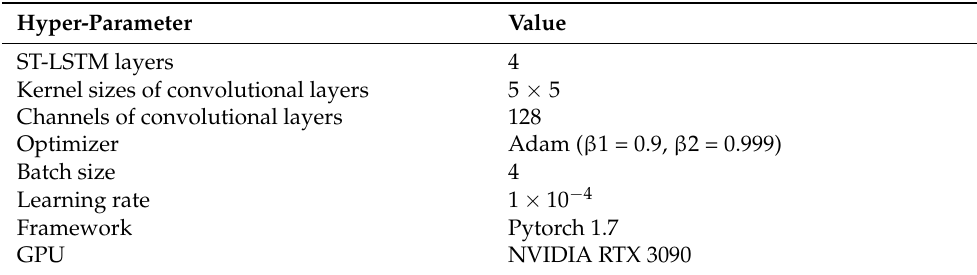
Table 1. Implementation details of the proposed method.